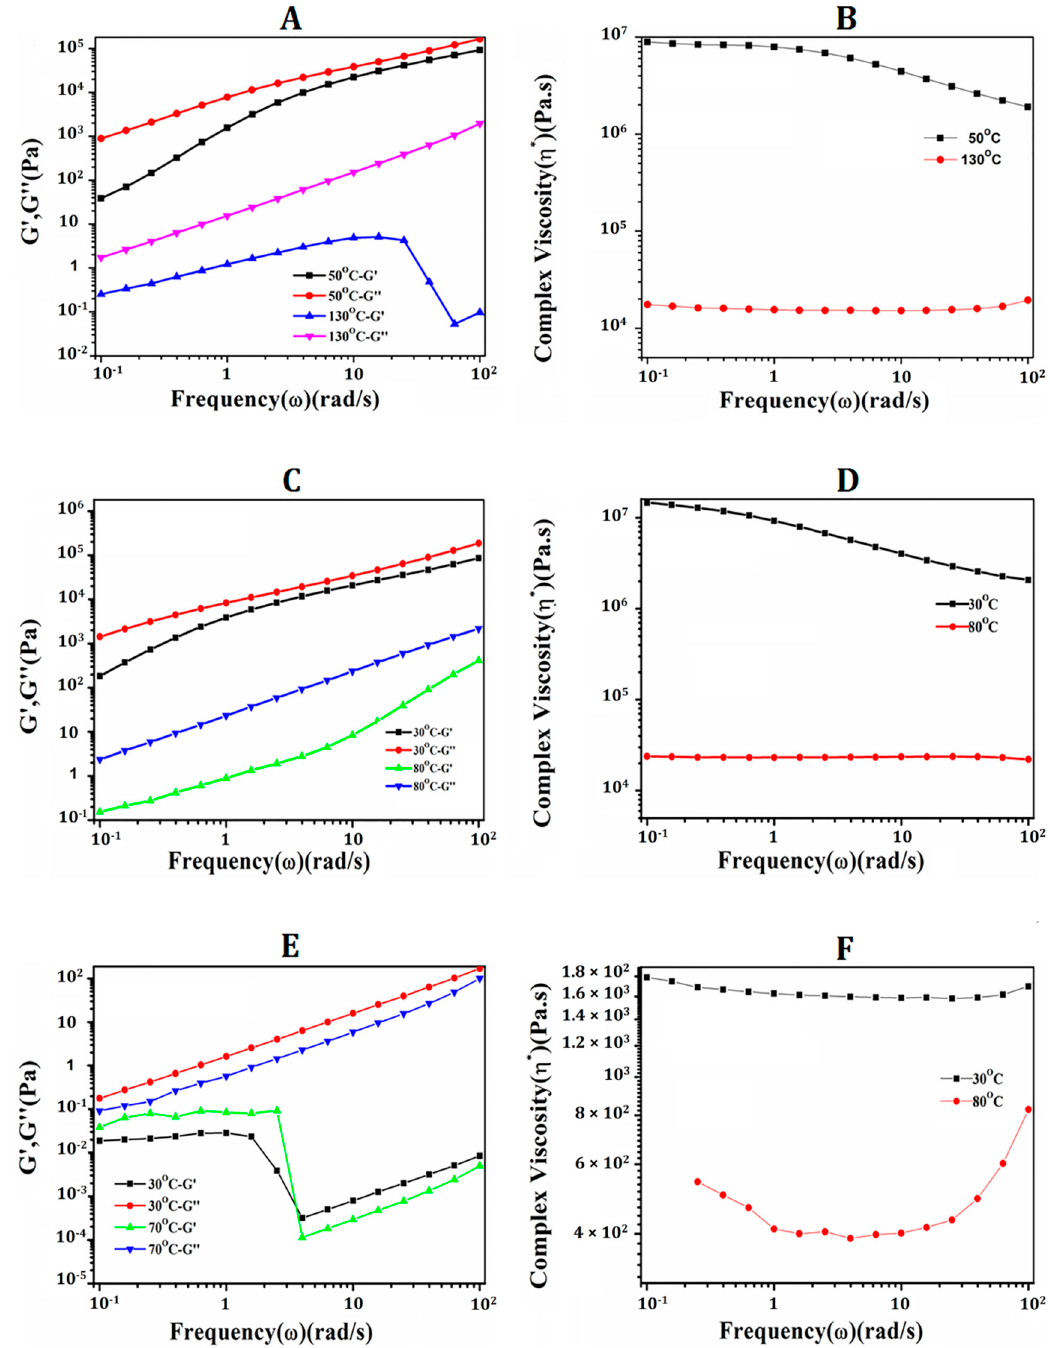
Figure 8. Variation in storage modulus (G ′ ), loss modulus (G ″ ) and complex viscosity ( η *) of styrene-PDPMA copolymers of varying styrene content at different temperatures. (Strain rate: 0.5%). Feed ratios for figures are, ( A , B )—Styrene 70 –PDPMA 30 , ( C , D )—Styrene 50 –PDPMA 50 and ( E , F )—Styrene 30 –PDPMA 70 .